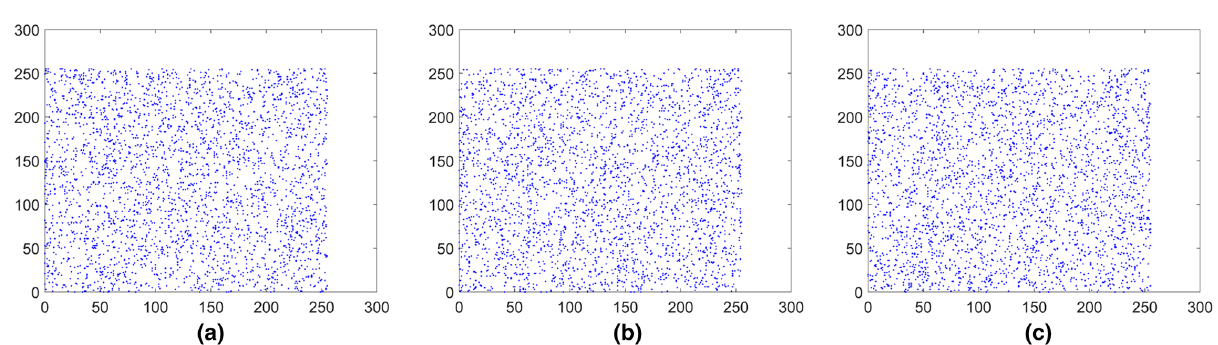
Figure 17. Distribution of adjacent pixels of the encrypted White. ( a ) Horizontal direction of the encrypted image, ( b ) vertical direction of the encrypted image, ( c ) diagonal direction of the encrypted image.